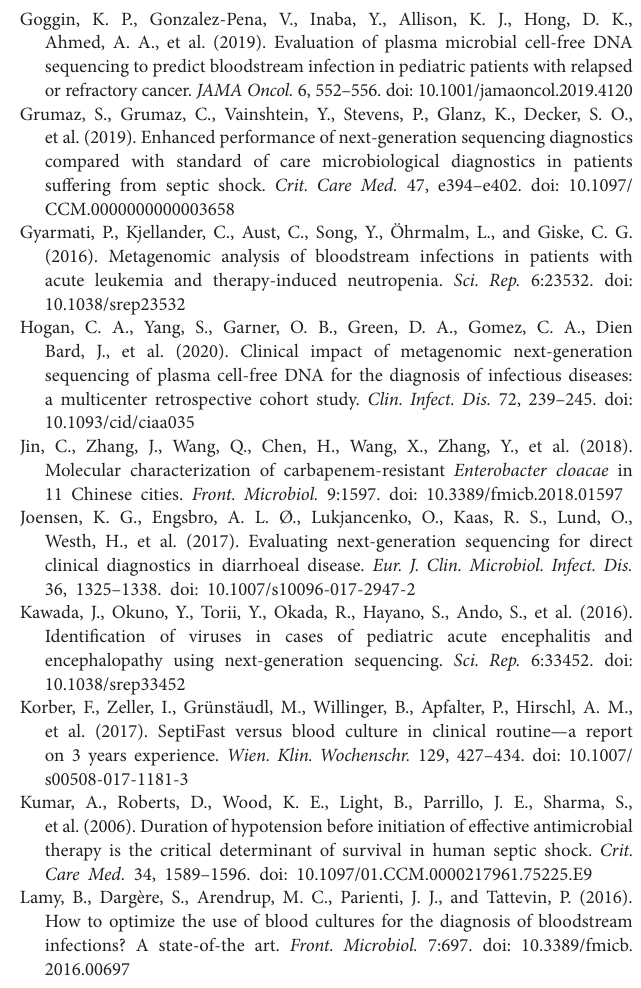
Supplementary Table 1 | Pathogens and AMR genes detection panels for ddPCR assay. Supplementary Table 2 | Comparison of the patients’